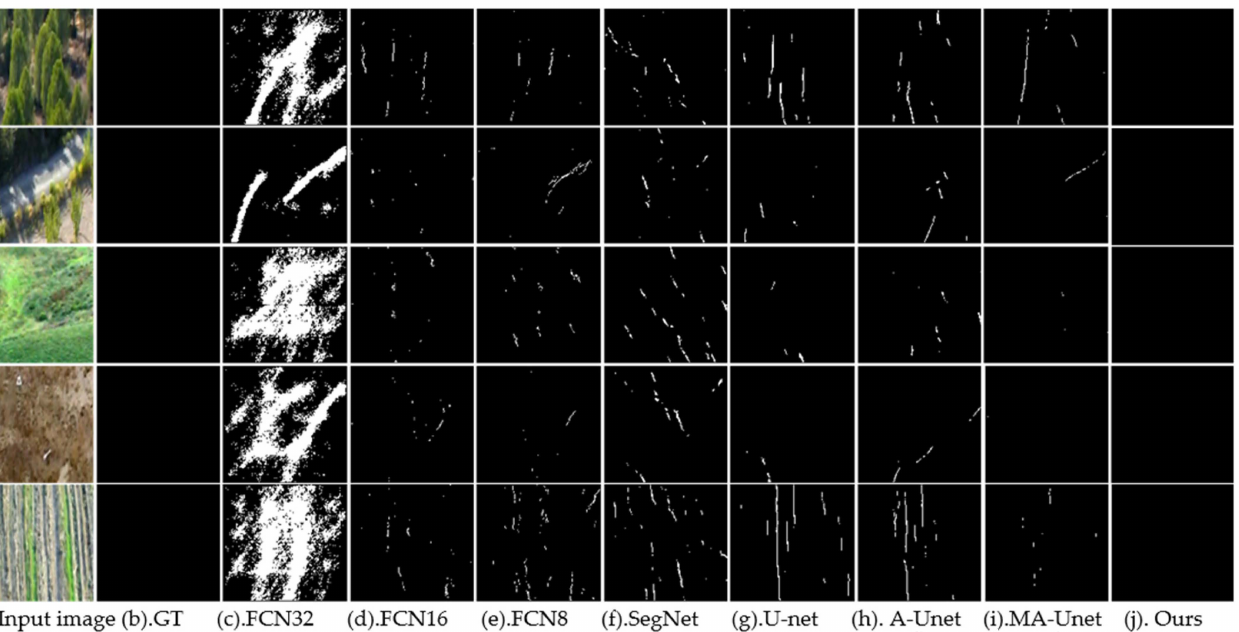
Figure 4. The PLE results of datasets without power lines. Other methods false detected edge lines more or less, the non-powerline scenarios are correctly recognized by the proposed